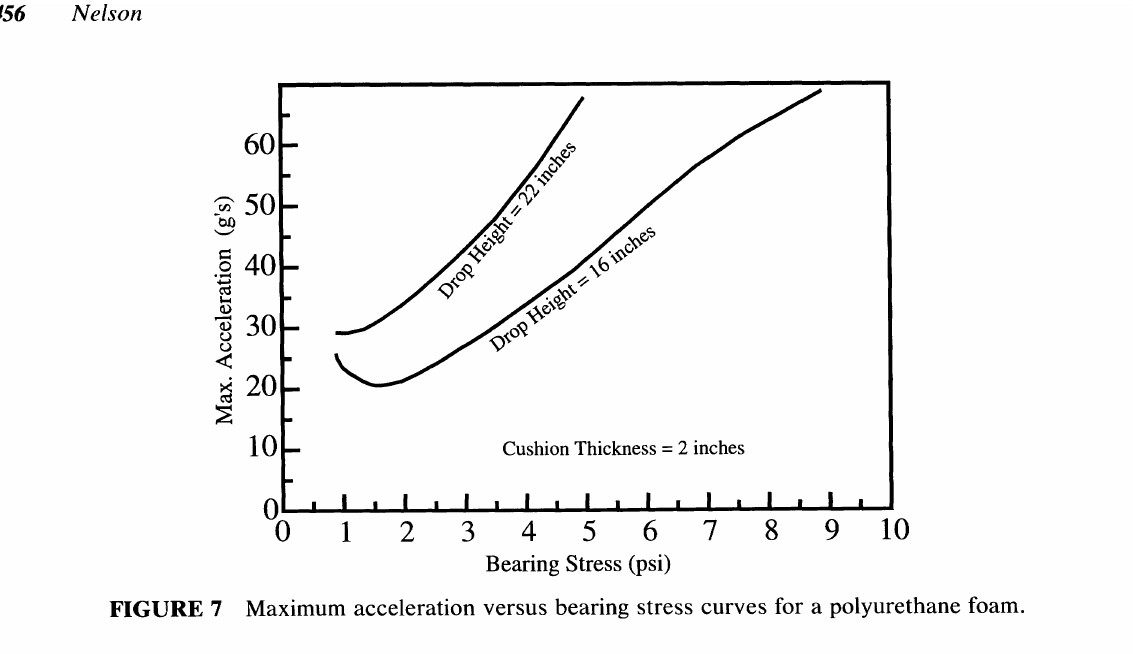
FIGURE 7 Maximum acceleration versus bearing stress curves for a polyurethane foam.